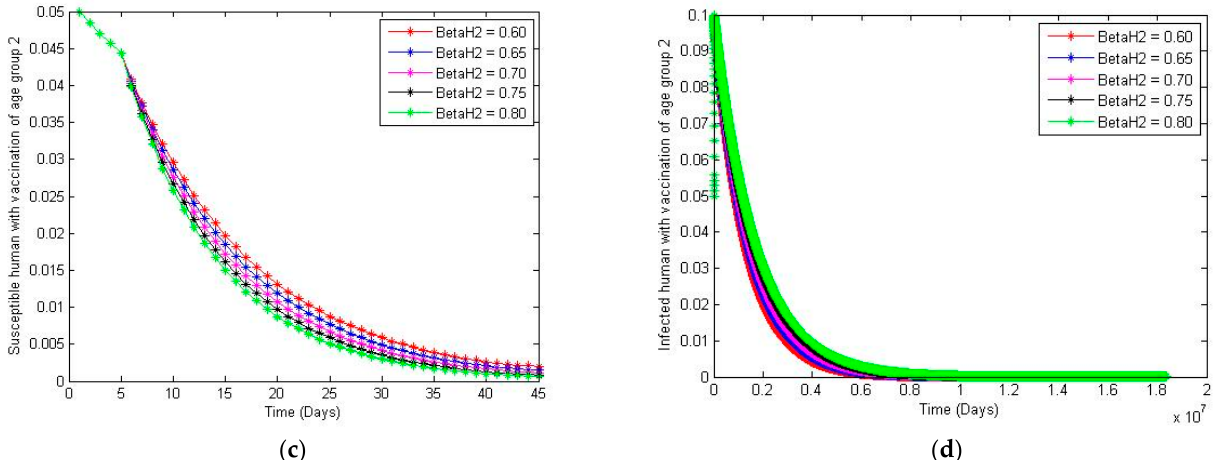
Figure 7. The trajectory of S H , I H , S H , and I H toward the endemic steady state, respectively. For R 0 > 1 ( a ) Susceptible human; ( b ) Infected human; ( c ) Susceptible human with vaccination; ( d ) Infected human with vaccination of age group 2.